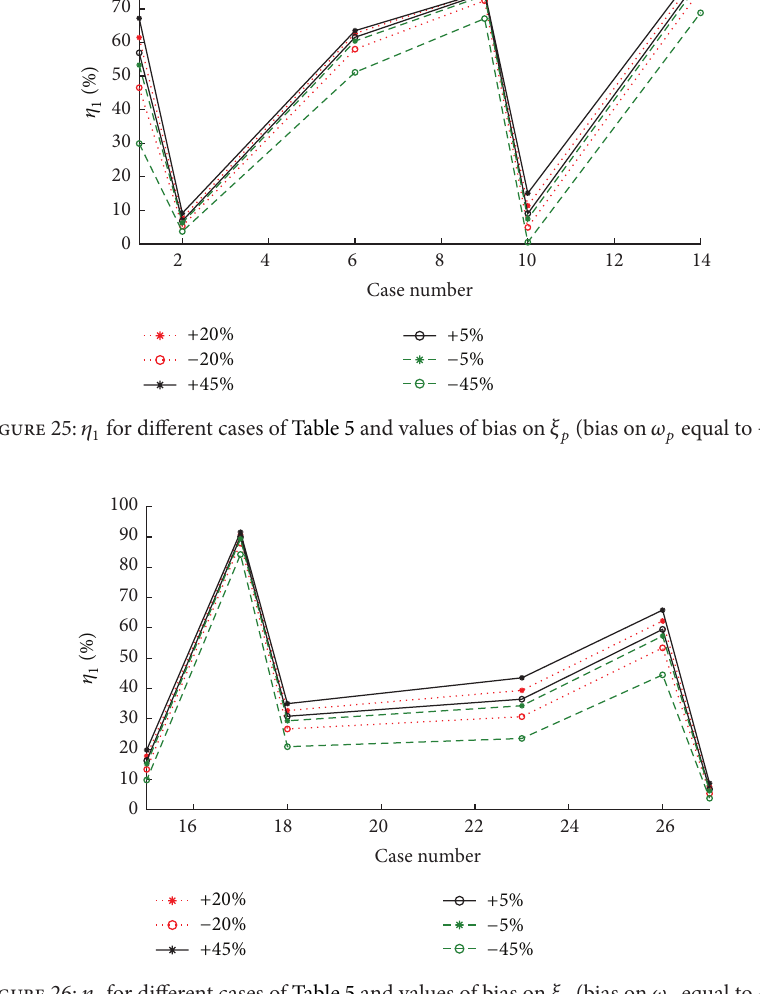
Figure 26: 𝜂 1 for different cases of Table 5 and values of bias on 𝜉 𝑝 (bias on 𝜔 𝑝 equal to +2%).